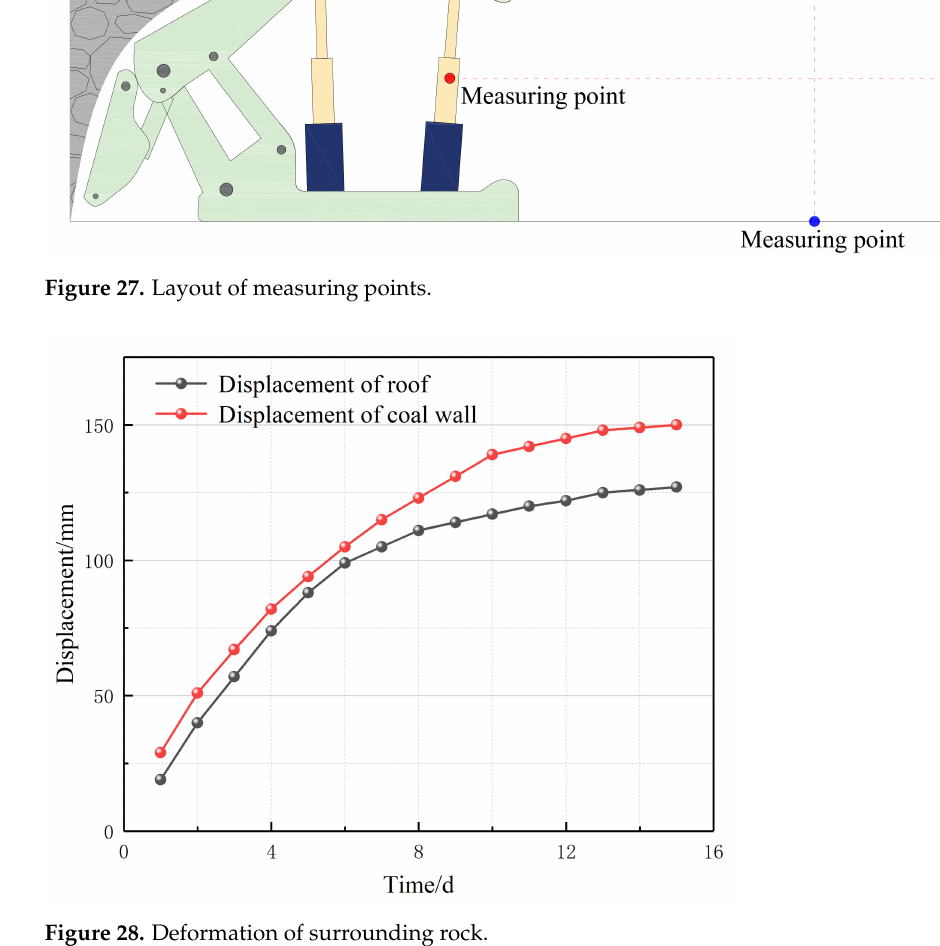
Figure 28. Deformation of surrounding